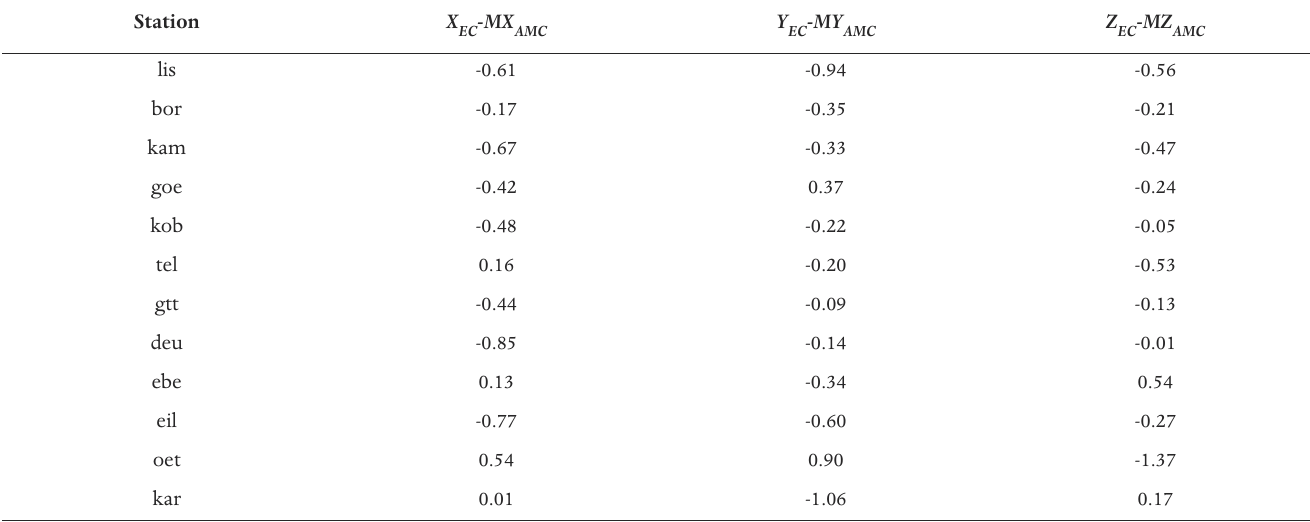
Table 5. Linear trends in nT/yr obtained for the different component residual time series.